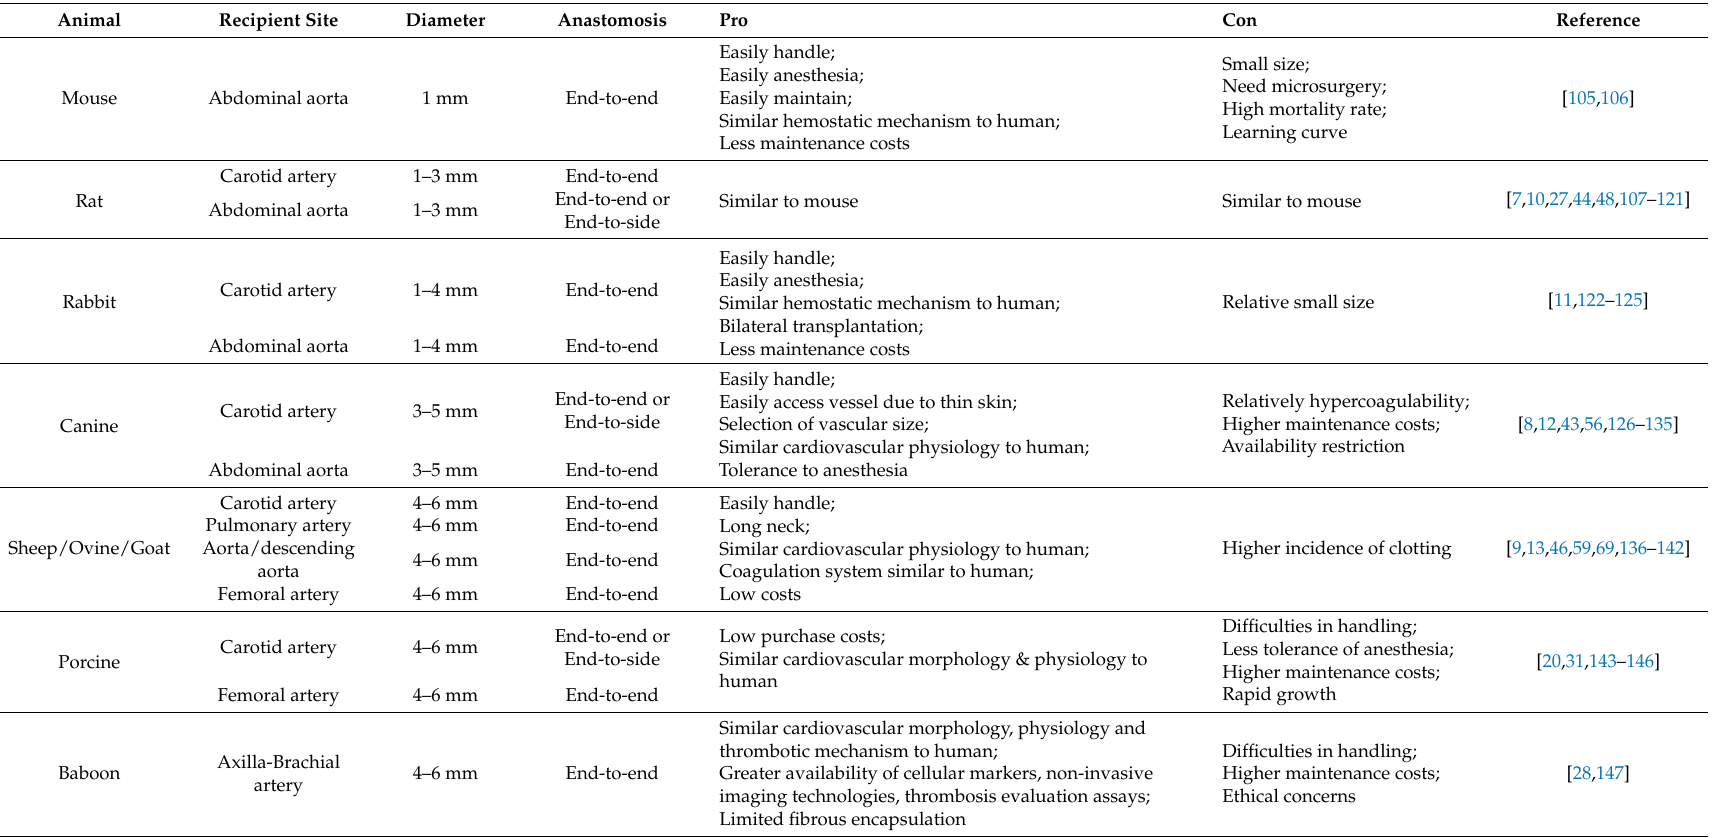
Table 1. Consideration in selecting animal models for decellularized vascular